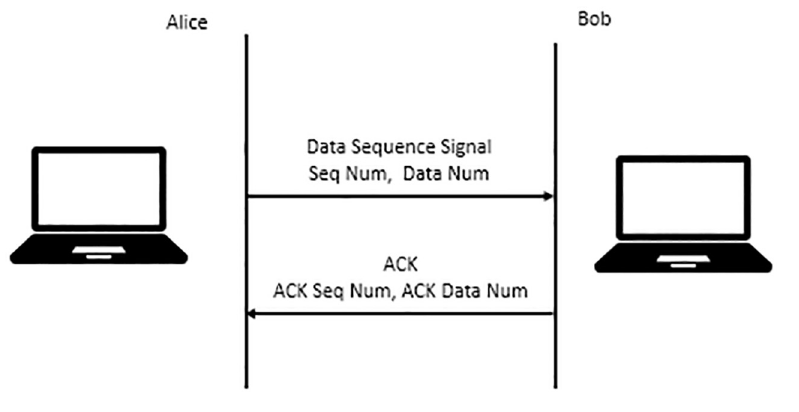
Fig 6. Transfer of data using MPTCP.